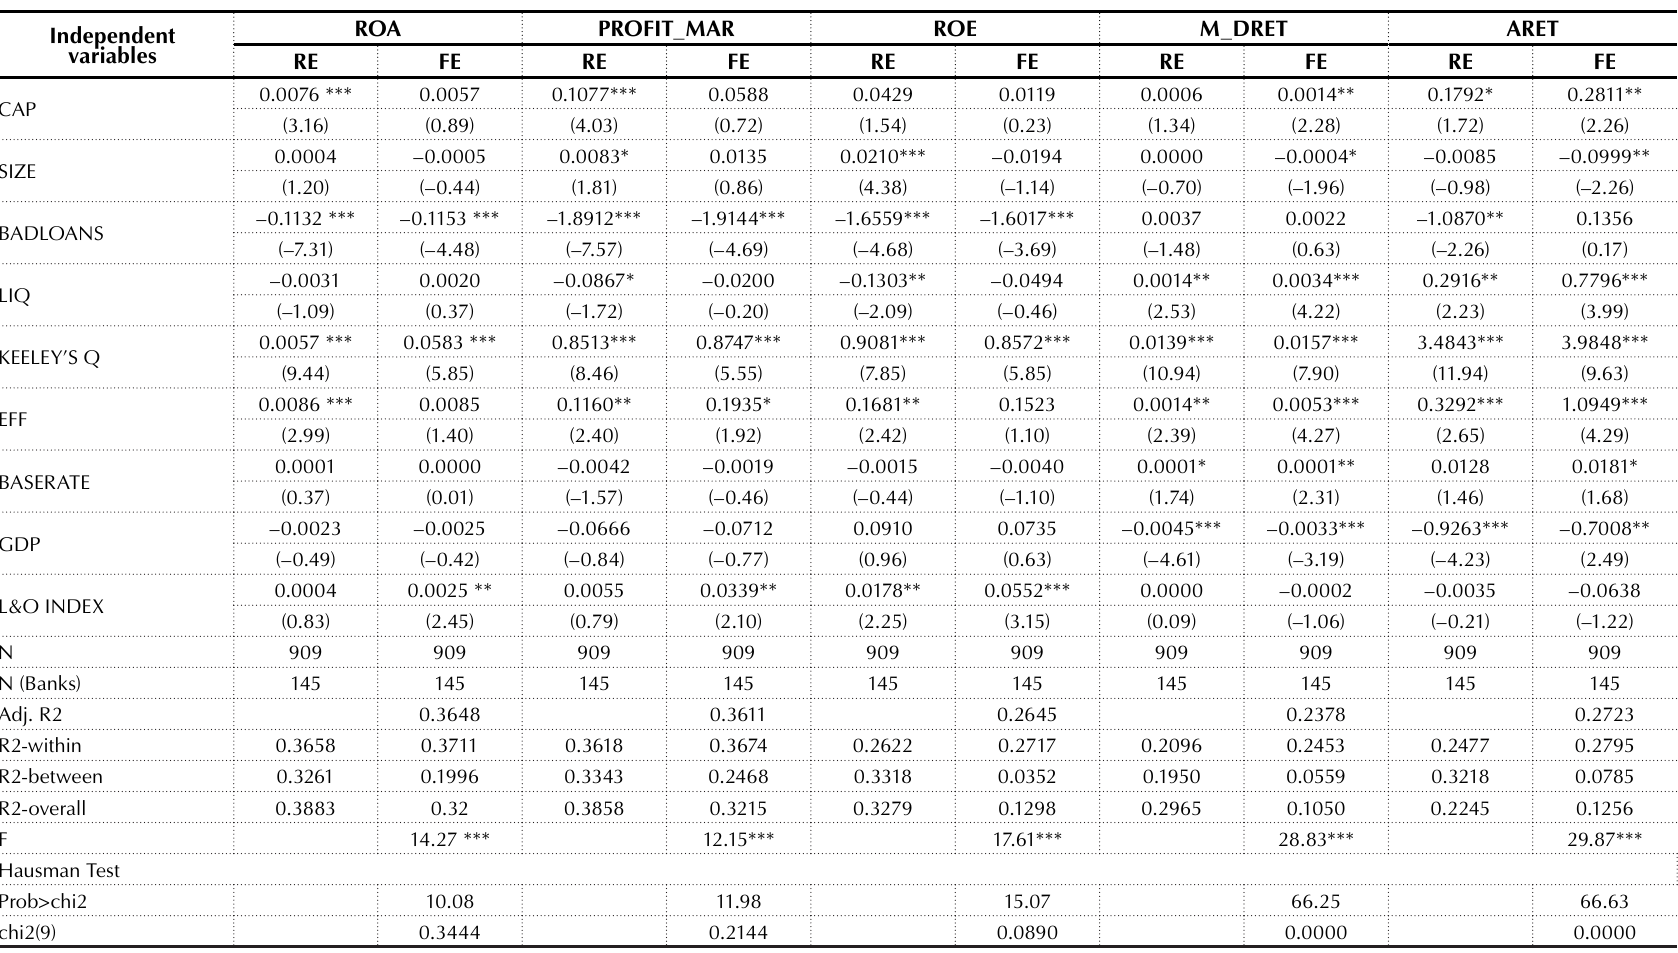
Table 7a. Regression results for accounting and market-based profitability measures for the European bank market from 1992 to 2012 Independent